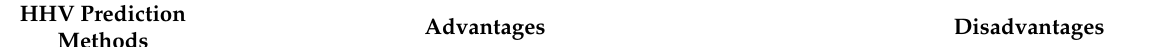
Table 1. Advantages and disadvantages of methods for predicting the higher calorific value [39–41,52,54,55]. HHV Prediction